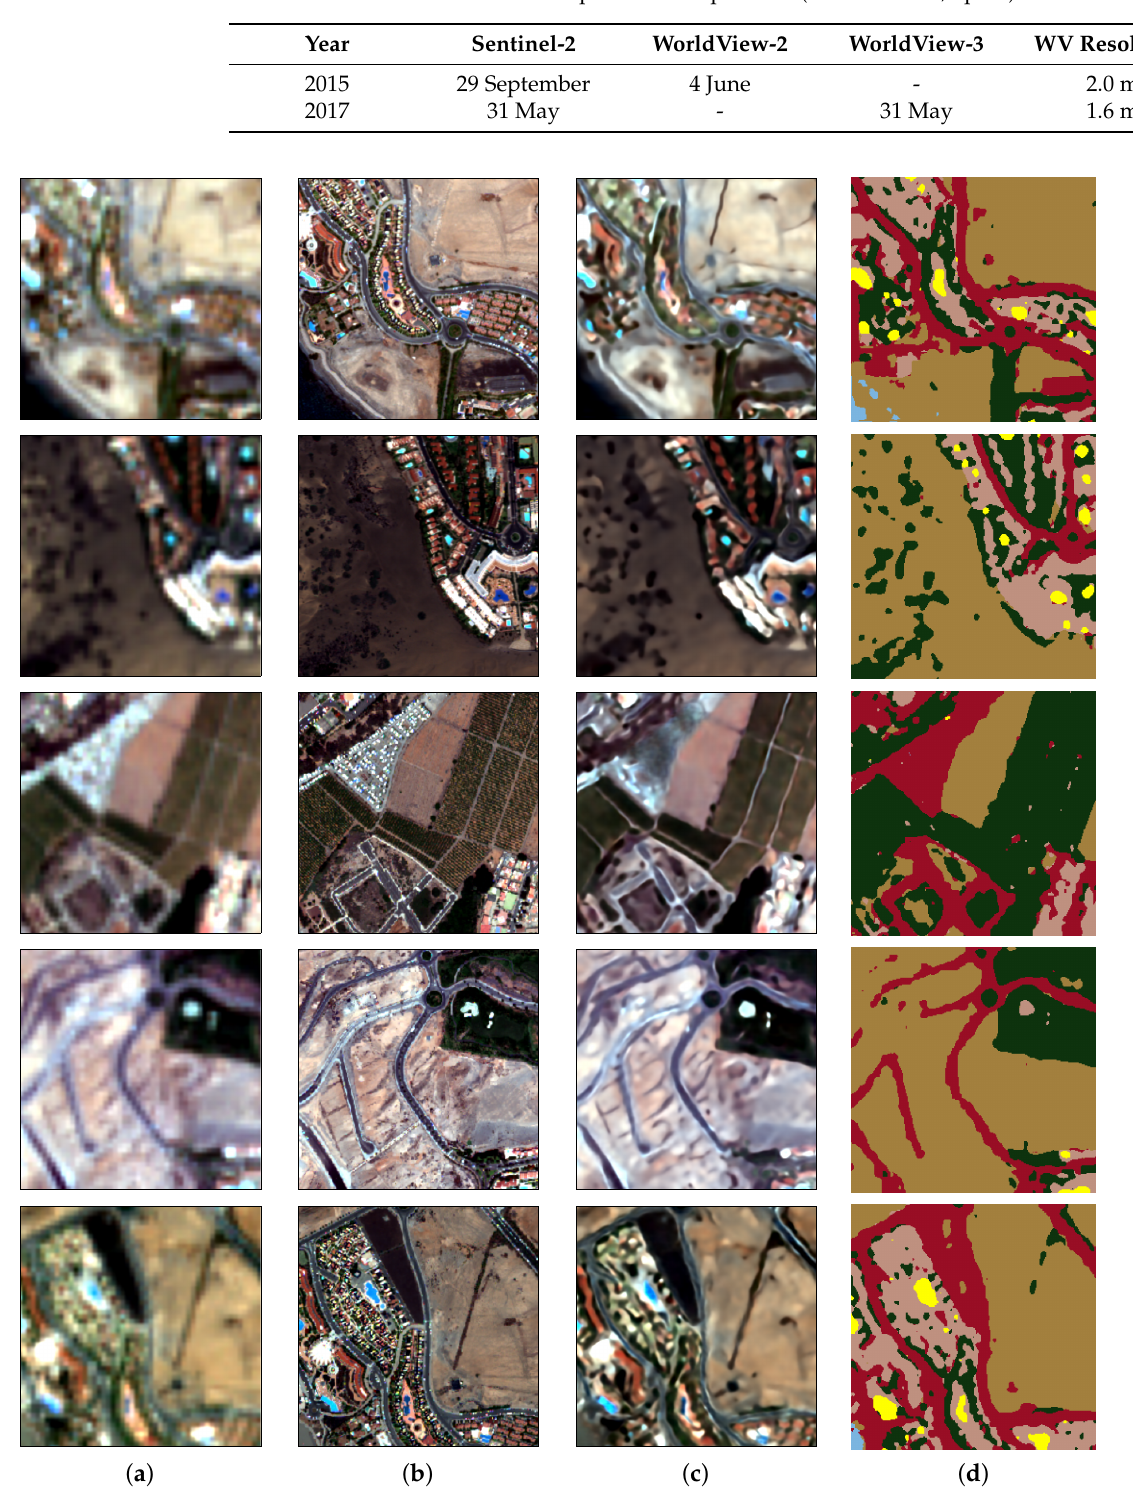
Figure 15. SEG-ESRGAN inference of other WorldView-Sentinel pairs that do not belong to the dataset. ( a ) Sentinel-2 bicubic image, ( b ) WorldView GT, ( c ) SISR, ( d )